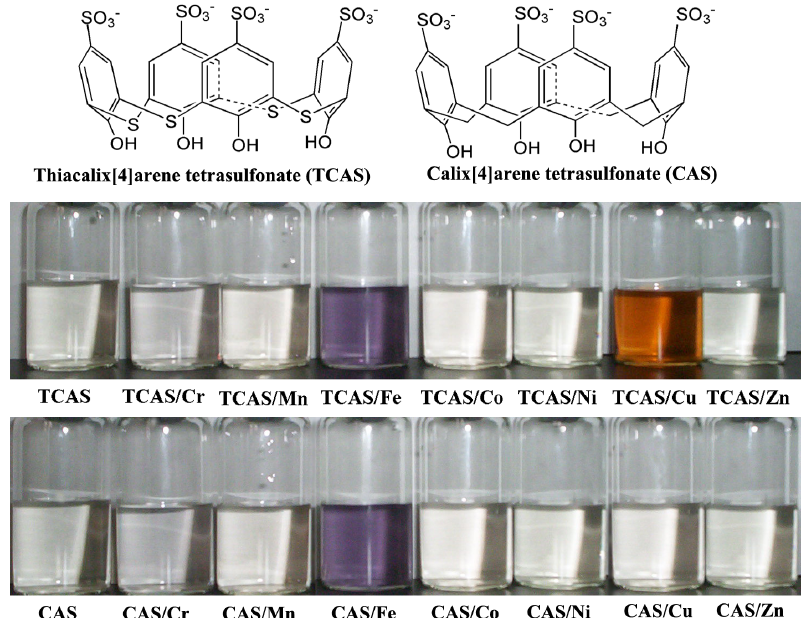
Figure 1. The molecular structures of thiacalix[4]arene tetrasulfonate (TCAS) and calix[4]arene tetrasulfonate (CAS), and color change in aqueous solution of TCAS and CAS upon addition of transition metal ions. The concentrations of TCAS and CAS are both 4.3 × 10 − 3 mol L − 1 , and the concentrations of all transition metal ions are 9.5 × 10 − 5 mol ∙ L − 1 .